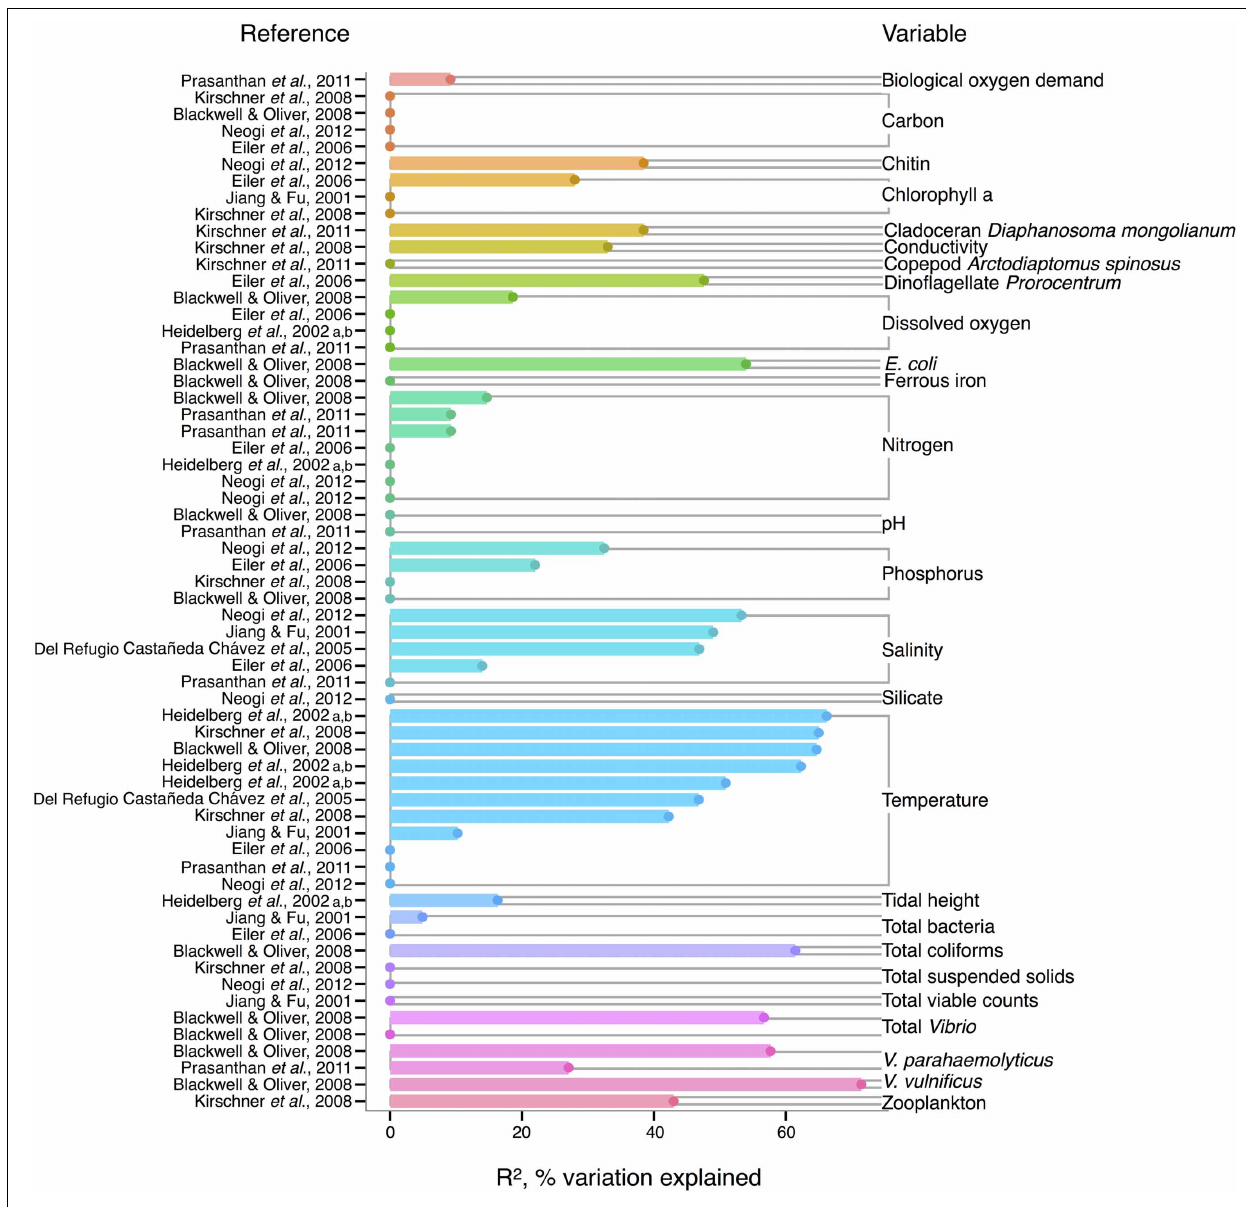
FIGURE 2 | Variation in V. cholerae abundance or percent positive samples is best explained by temperature, other organisms, and salinity. R 2 , or pseudo- R 2 , values from analyses across studies are depicted grouped by variable, and then in rank order, with their associated reference. A